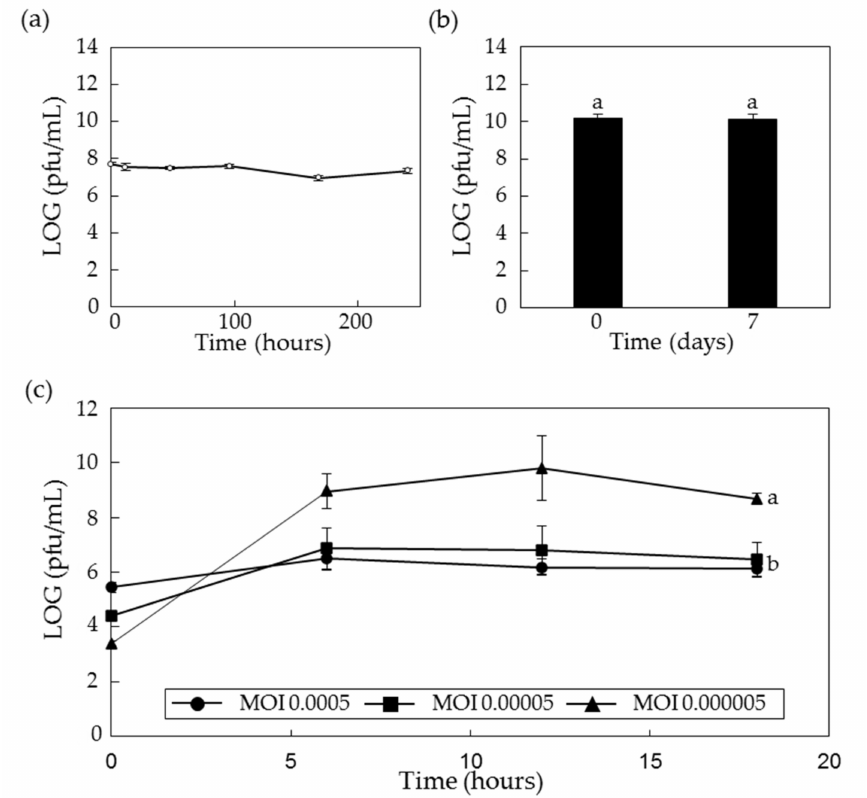
Figure 5. Stability of PPPL-1 phage in the field soil at 26 ◦ C ( a ) and low temperature (0–2 ◦ C) ( b ) and also minimum MOI for scaled-up production ( c ). The phages of 10 8 pfu/mL for ( a ) and 10 10 pfu/mL for ( b ) were used for assays. The phage was incubated with host bacteria (OD 600 = 0.5) at three different MOIs, and the phage concentration was measured at the indicated time points ( c ). Error bars indicate standard deviations of three replicates ( n = 3), and the alphabets on the top of error bars ( a ) or in the next lines ( b ) indicate the different groups based on significant differences at p < 0.05 by Duncan’s multiple range